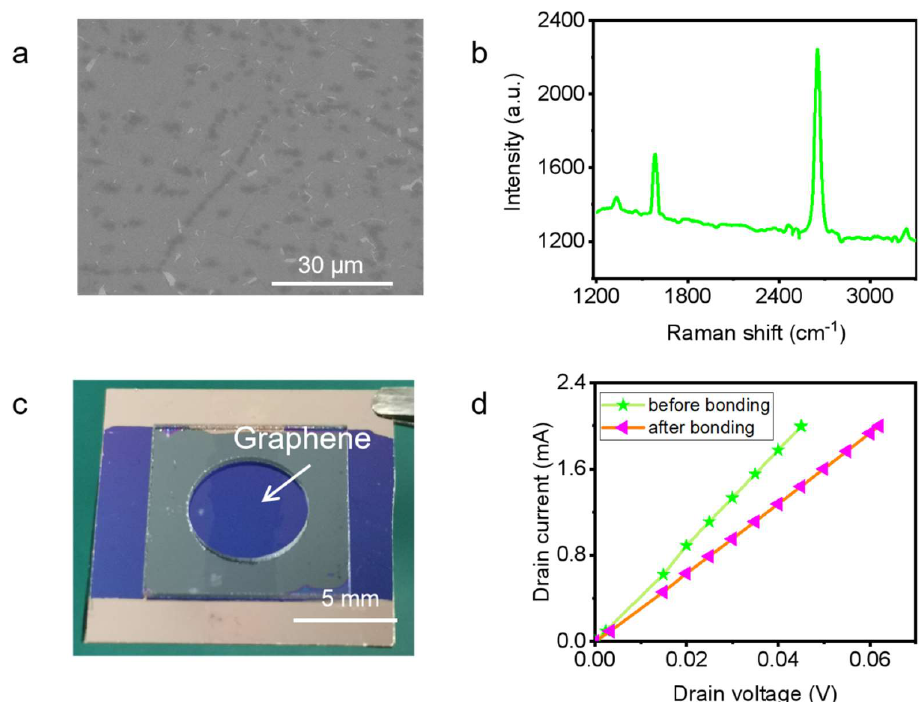
Figure 2. Characterization of graphene electrode. ( a ) An SEM image of the graphene after transferring; ( b ) Raman spectrum of monolayer graphene; ( c ) A photograph of measuring the conductance of graphene electrode; ( d ) I − V curves of graphene electrode before and after bonding.